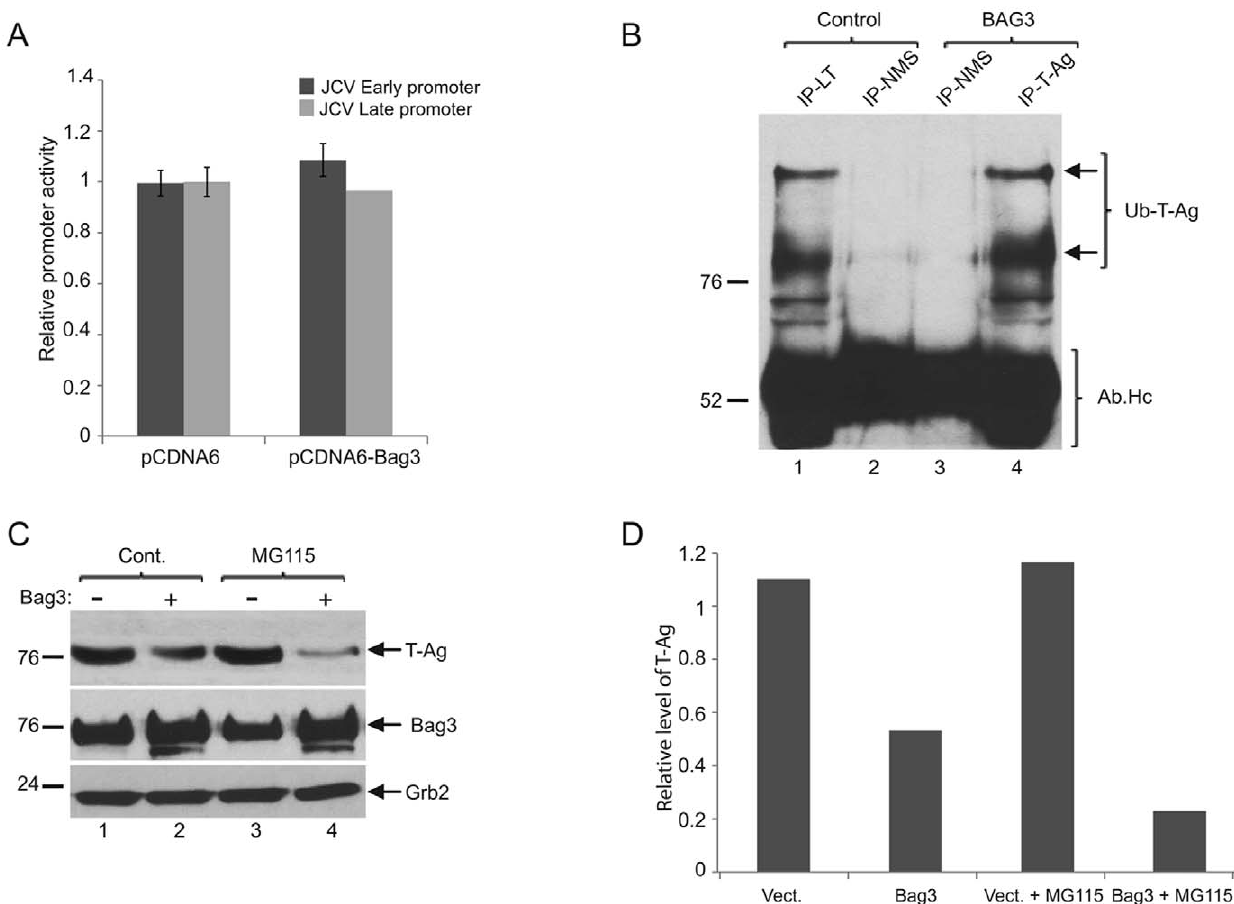
Figure 3. Effect of proteasomal inhibitors on Bag3-mediated downregulation of Large T antigen expression. A. Effect of Bag3 on transcription of JCV promoters. Primary culture of human fetal glial cells was transfected with CAT reporter genes under the control of JCV early or late gene promoters along with a plasmid expressing Bag3 (pCDNA6-Bag3), or a control empty vector (pCDNA6). Relative promoter activity was determined as described in the Materials and Methods. B. Protein extracts were prepared from BSB8 cells transfected with plasmid vector (control) or expression plasmid encoding Bag3. Large T-Ag was immunoprecipitated with a monoclonal antibody, separated on SDS-PAGE gel, and processed for Western blotting using anti-Ubiquitin antibody. Normal mouse serum (NMS) was used as negative control for immunoprecipitations. C. BSB8 cells were transfected with an expression plasmid encoding Bag3, and treated with MG-115 or DMSO (control). Whole cell extracts were prepared at 48 hour post-transfection, and Western blot analysis was performed for the detection of Large T, and Bag3 proteins. Western blot analysis of the same extracts with anti-Grb2 antibody was used as loading control. D. Relative band intensity of T-Ag bands from Panel B is shown as a bar graph.